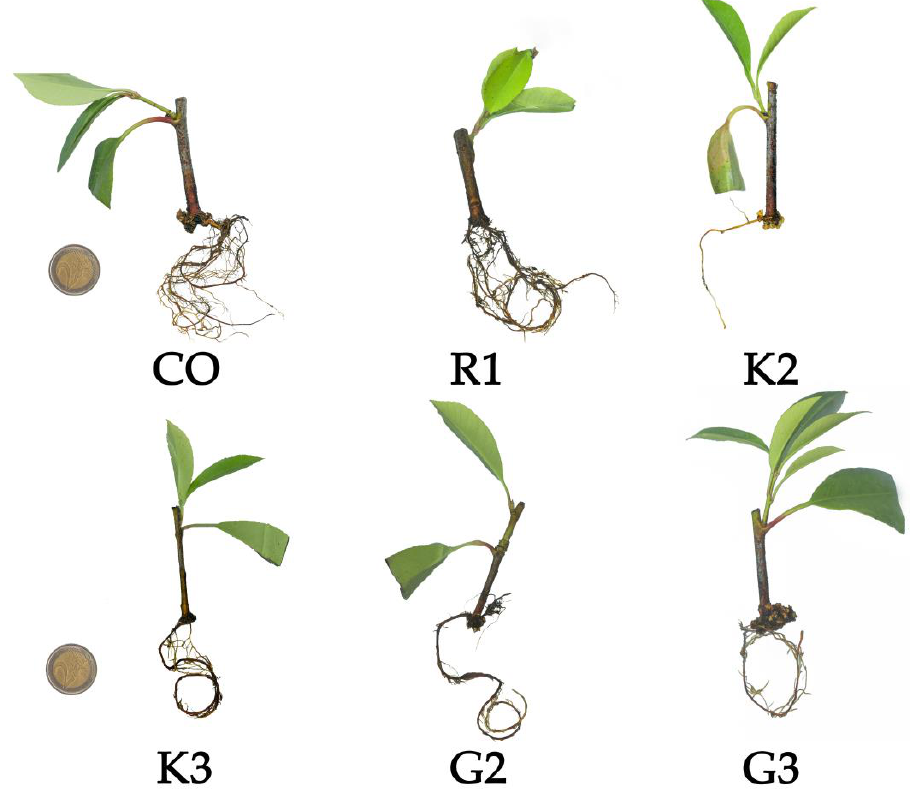
Figure 2. Root architecture in P. x fraseri ‘Red Robin’ influenced by application of rooting promoters concentration.